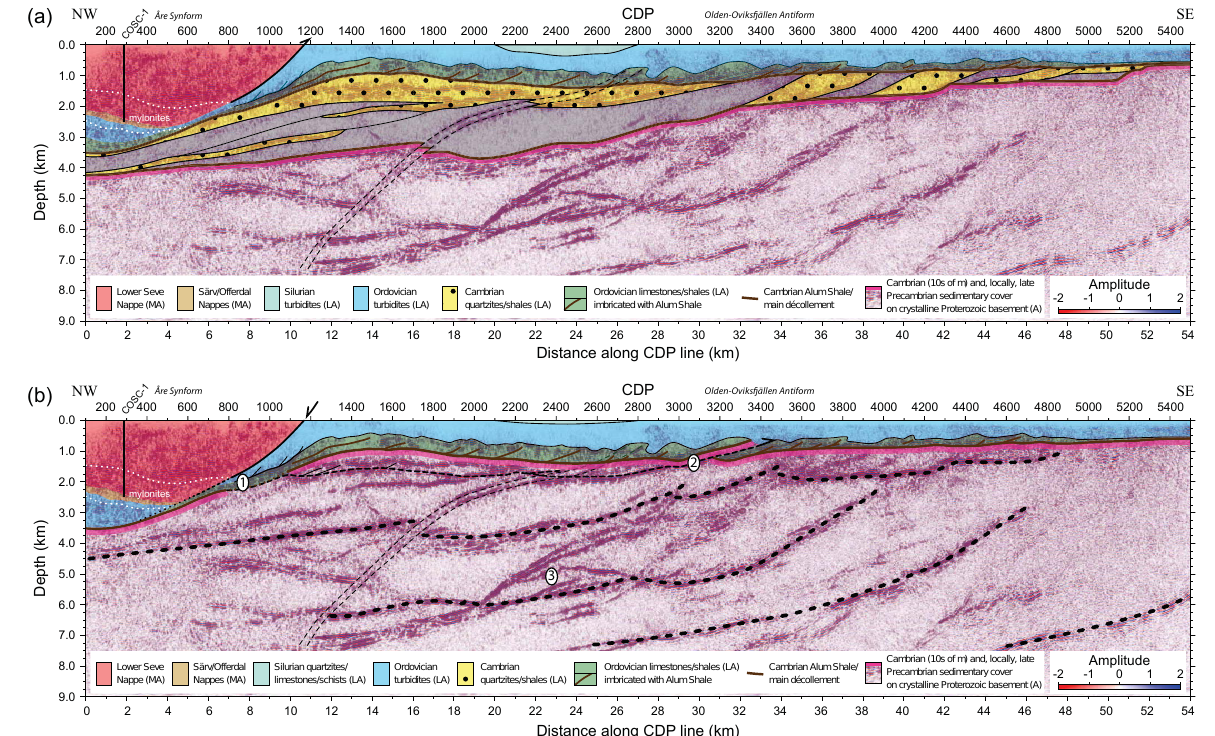
Figure 9. Interpretations of the CSP data. In (a) the focus is on the sole thrust. The interpretation west of CDP 2800 is the same as in Hedin et al. (2012) and shows significant basement involved thrusting; farther east, the sole thrust is shown to ramp up to join the Jämtlandian décollement near the thrust front. In (b) the Jämtlandian décollement is shown to dip very gently westwards, lying only a few hundreds of meters below the top of the alum shales, as interpreted from the CSP and the MT data. A second level of detachment may exist in the shallow basement reflectors below CDP 1000 to 3200. Numbers (1), (2), and (3) are referenced in the